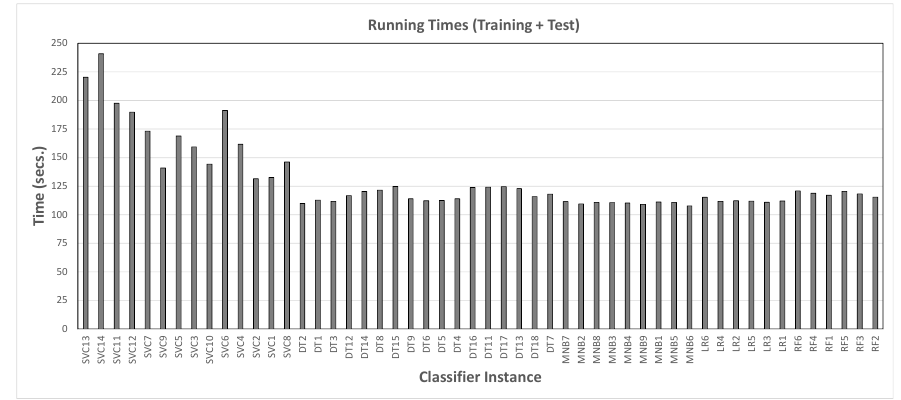
Figure 4. Running time taken to train and test each classifier instance from Phase 1, sorted by their F1 measure in the charts from Figure